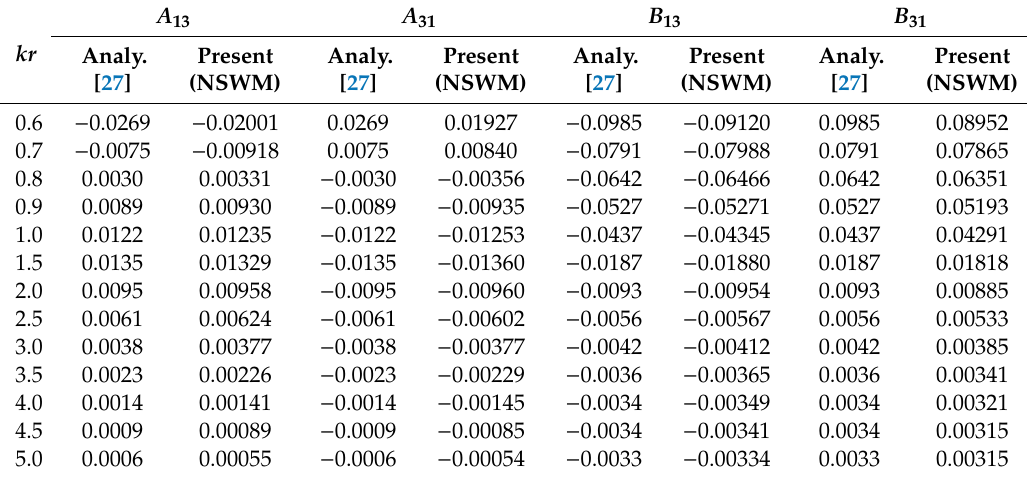
Table 6. Coupling added masses and damping coe ffi cients of the sphere ( Fr = 0.4, h = 2.0 r , k ec r =